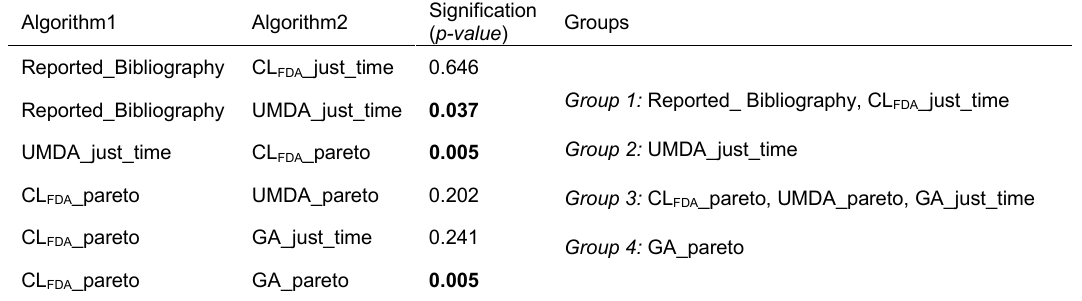
Table 4. Comparison results using Wilcoxon test, variable StdDev_Makespan for j30_17 dataset